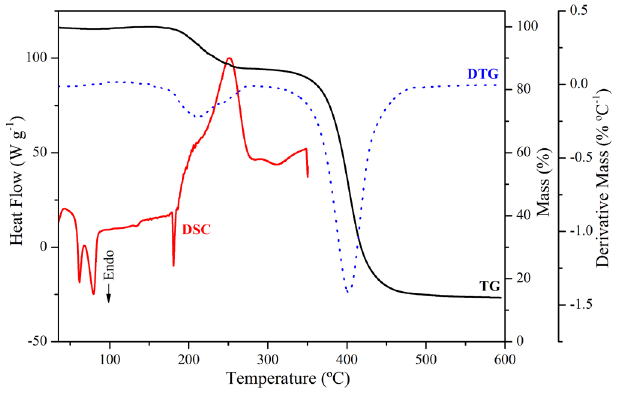
FIGURE 1 - DSC and TG curve of VAL.